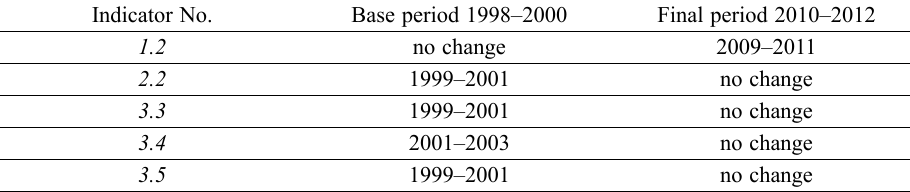
Table A3. Number and percentage of incomplete data* for indicators and countries Indicator